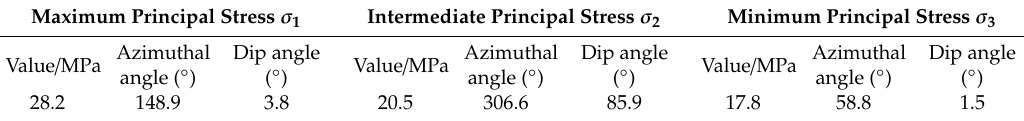
Table 5. Principal stress results for the test points in the PDS No. 1 coal mine.